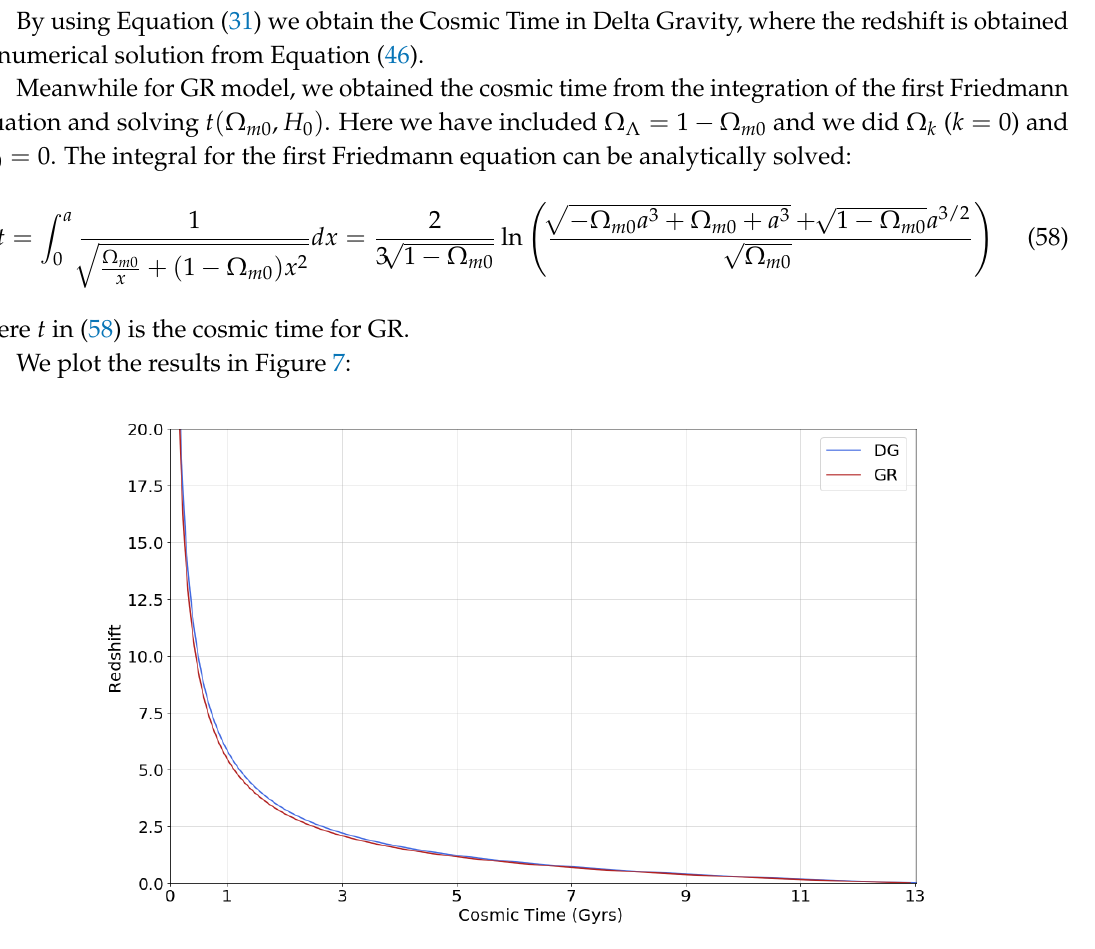
Figure 7. cosmic time for GR and Delta